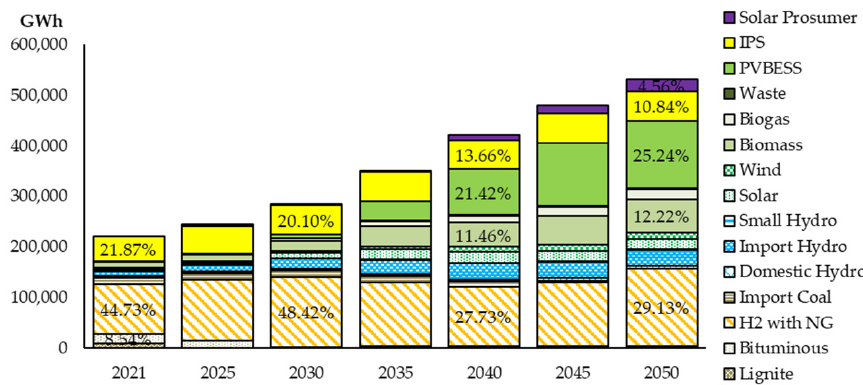
Figure 18. Fuel mix ratio of the 75% hydrogen scenario.